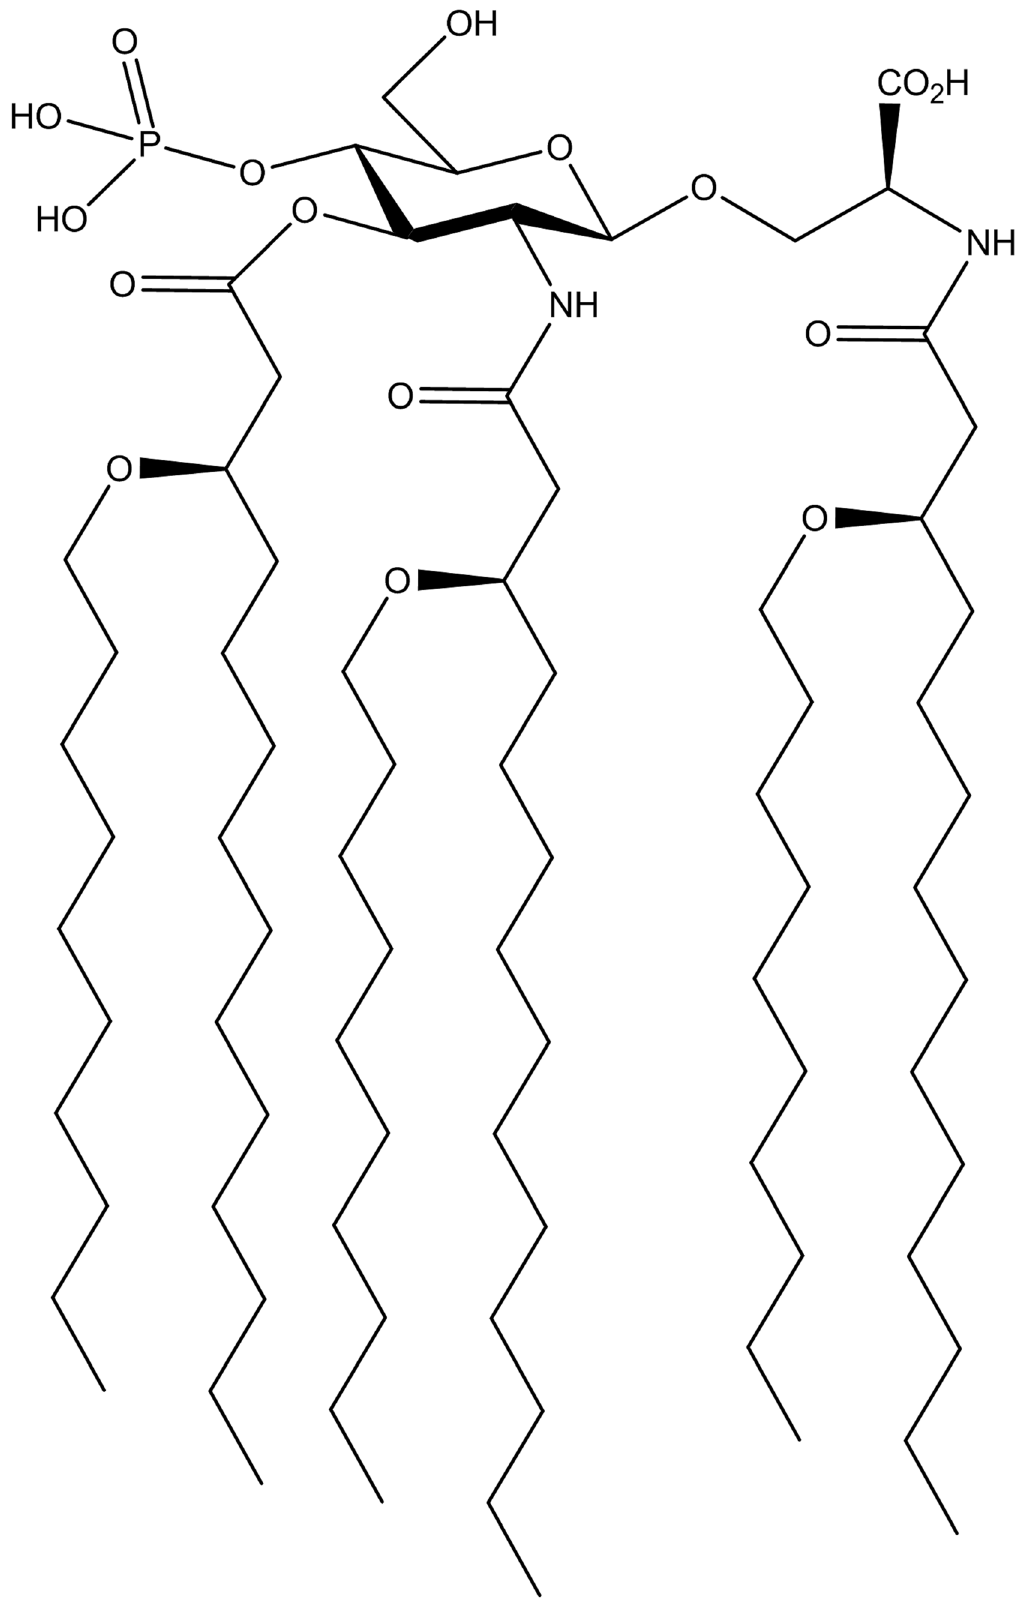
Figure 1. Chemical structure of CRX-601.